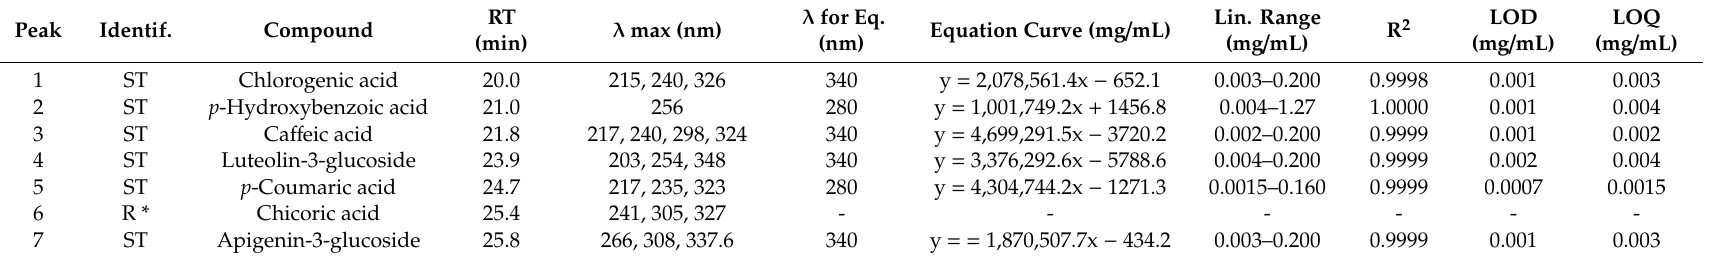
Table 2. Retention times (RTs), λ max, λ for eq., equation curves, linearity ranges, R 2 , LOD (limit of detection) and LOQ (limit of quantification) for all the identified standard compounds (ST).